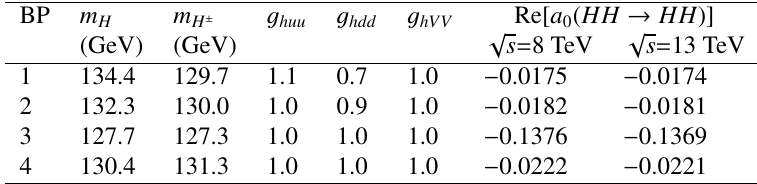
Table 2. Masses of Higgs bosons, couplings and partial wave values for the process HH the assumption m A = 28 GeV, m h = 125 GeV